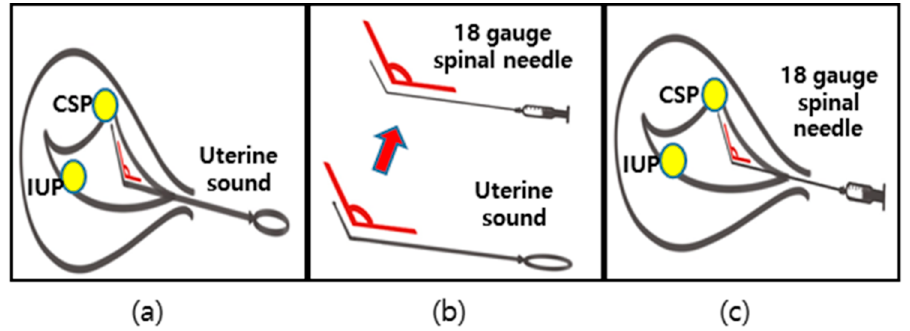
Figure 2. Schematic procedures for embryo reduction. ( a ) A uterine sound was inserted to reach the CSP. ( b ) A spinal needle bent at an equal angle to the sound was then guided along to locate the CSP. ( c ) Potassium chloride was injected via spinal needle into the CSP.